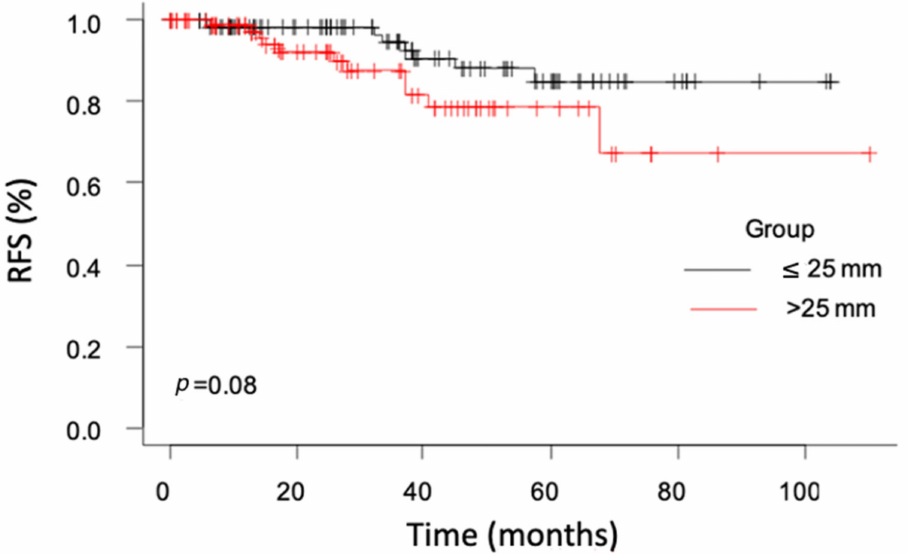
Figure 1. Recurrence-free survival between the two groups. Trifecta Achievement